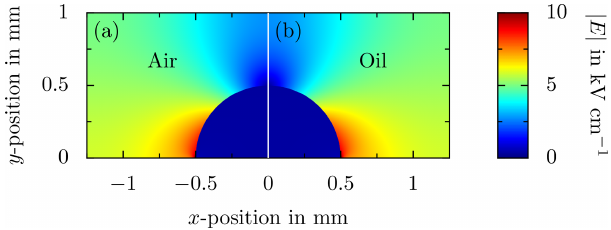
Figure 11. Comparison of the electric field distribution for a droplet deposited onto a rigid substrate between two plate electrodes for (a) air and (b) oil as the surrounding fluid. An alternating voltage of ˆ U = 10kV ( f = 50Hz) is applied between the electrodes, resulting in ˆ E = 4kVcm − 1